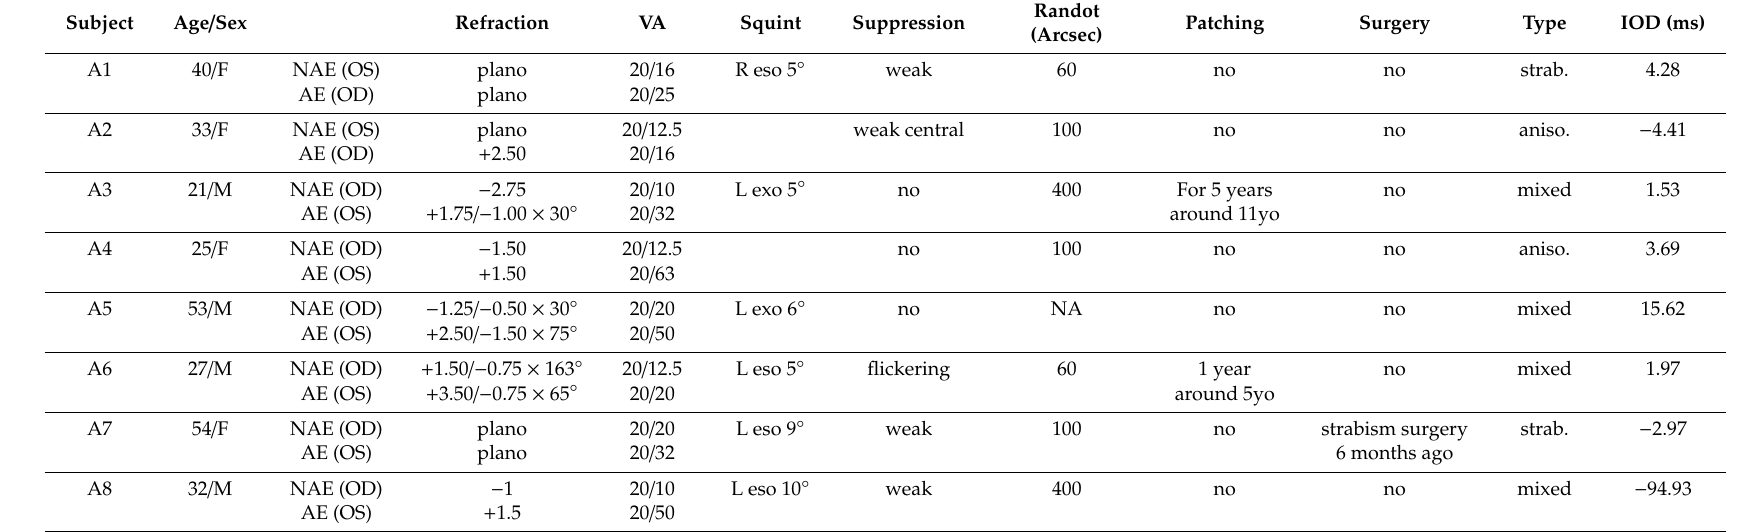
Table 1. Clinical details of amblyopic subjects. VA: visual acuity, strab.: strabismus, aniso.: anisometropia, NAE: non-amblyopic eye, AE: amblyopic eye, exo: exotropia, eso: esotropia, IOD: interocular delay. Suppression was measured with the Bagolini striated glasses test. Estimated interocular delay IOD is reported in the last